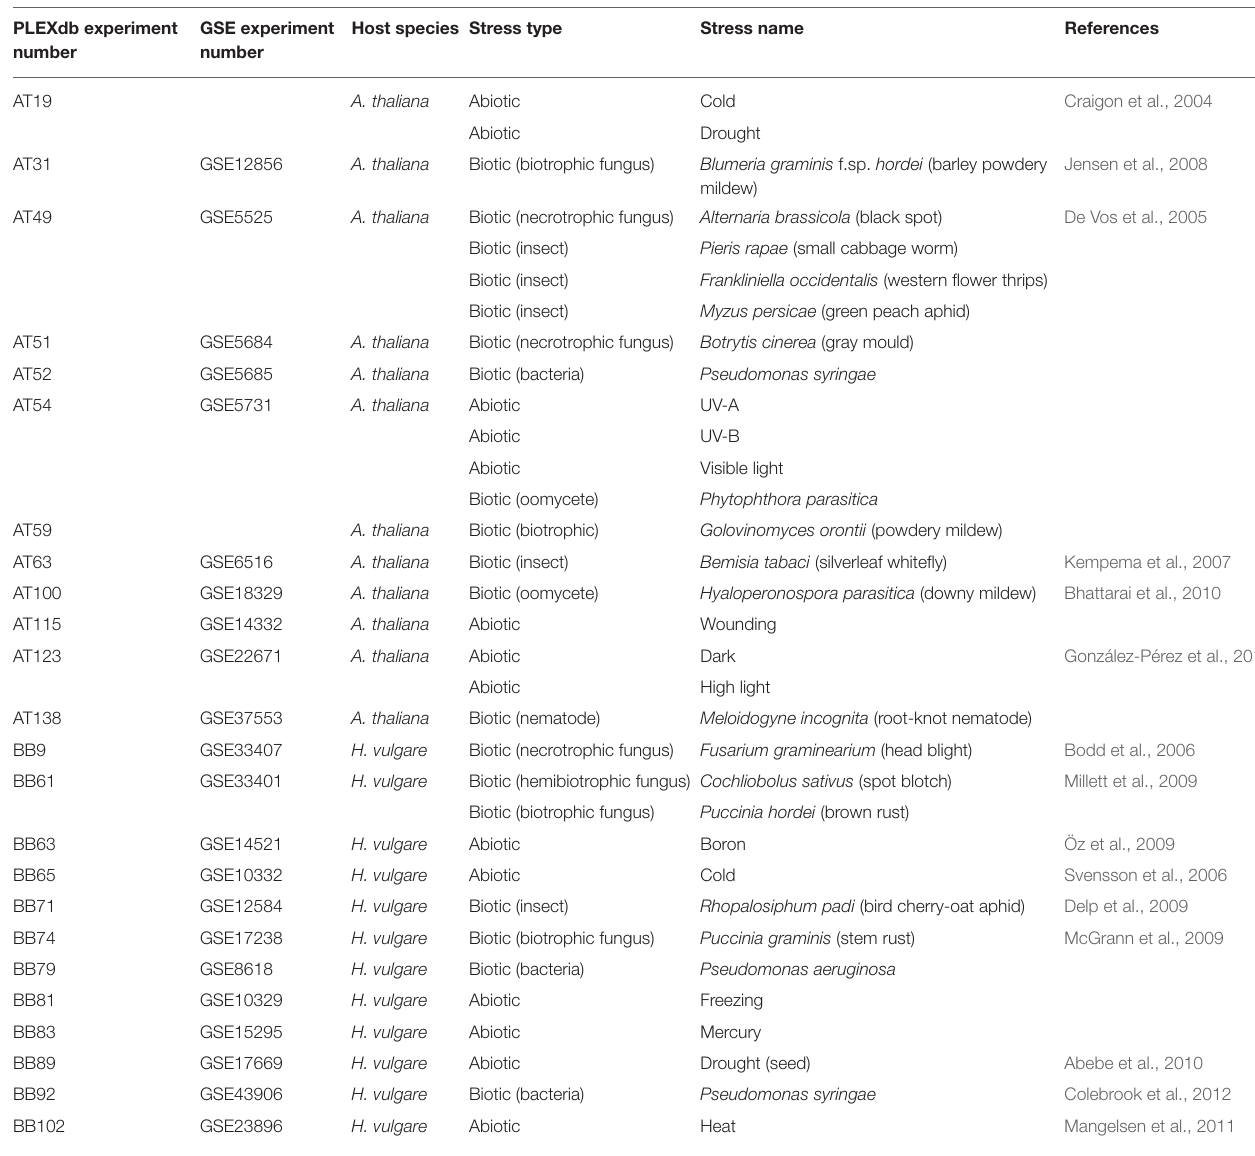
TABLE 2 | Plant:stress systems collated from PLEXdb for meta-analysis. PLEXdb experiment